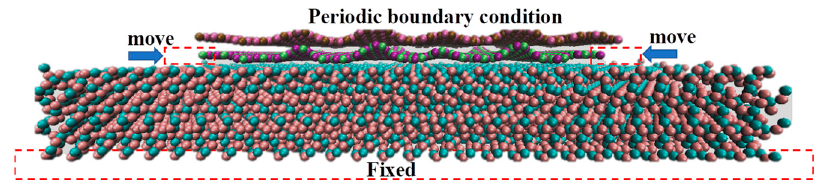
Figure 4. The simulation model.